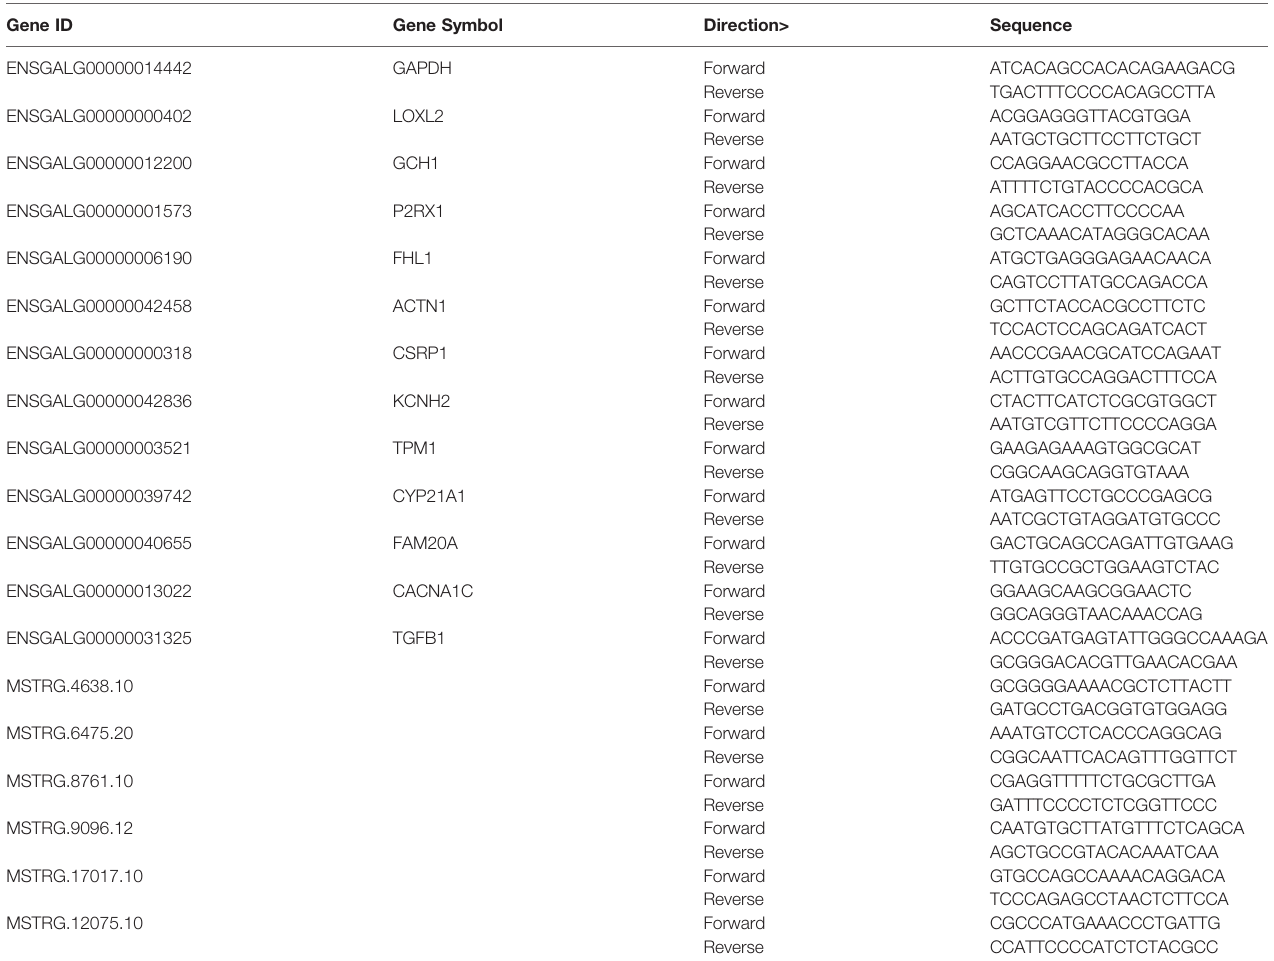
TABLE 1 | Primers for differentially expressed mRNAs and lncRNAs used in RT-qPCR. Gene ID Gene